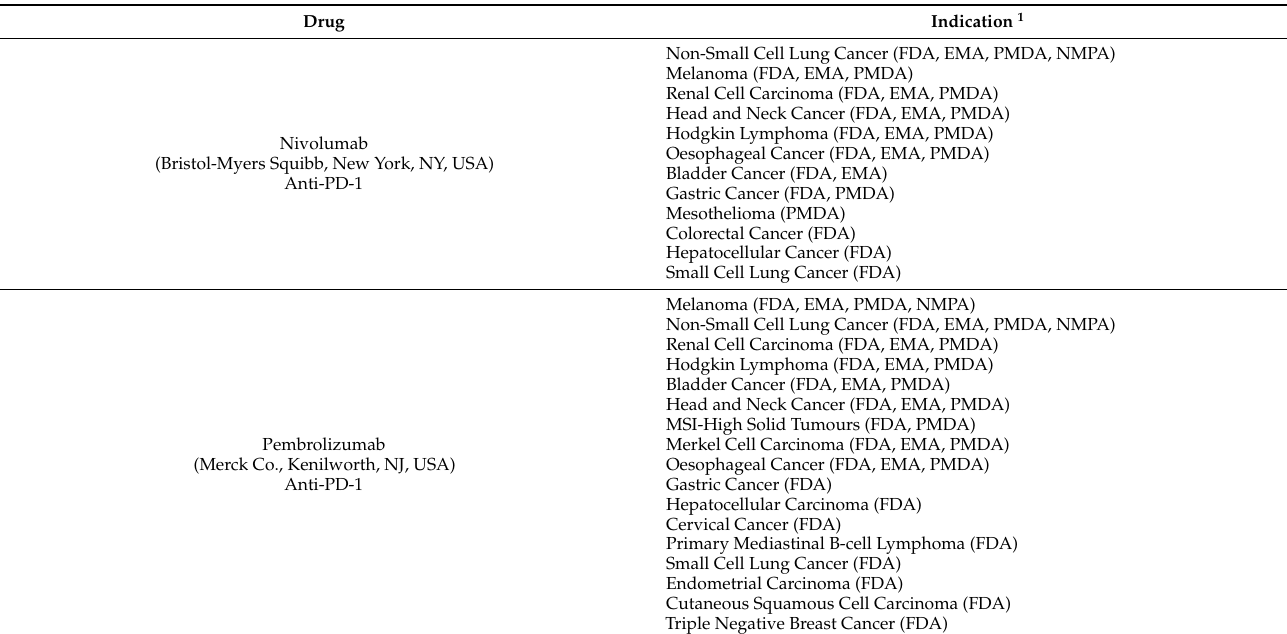
Table 1. List of anti-PD-1/PD-L1 immune checkpoints inhibitors that have been approved by different government agencies. Drug Indication